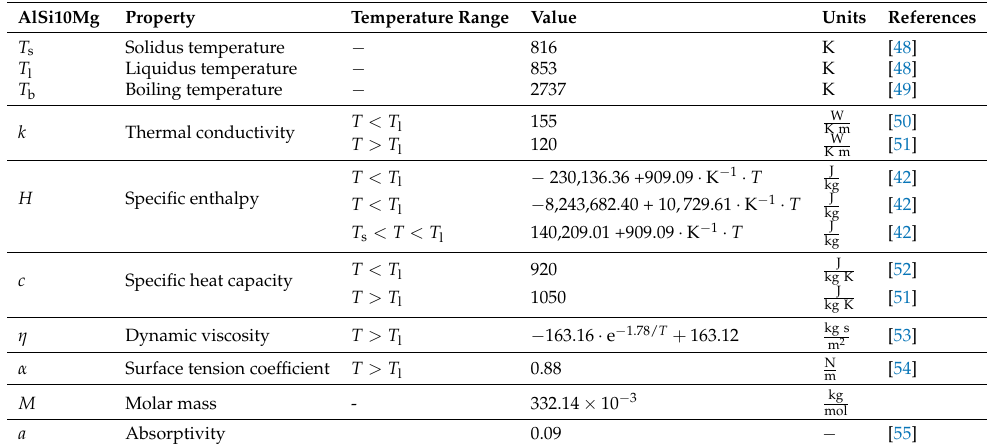
Table A2. Material properties of AlSi10Mg for the simulations.